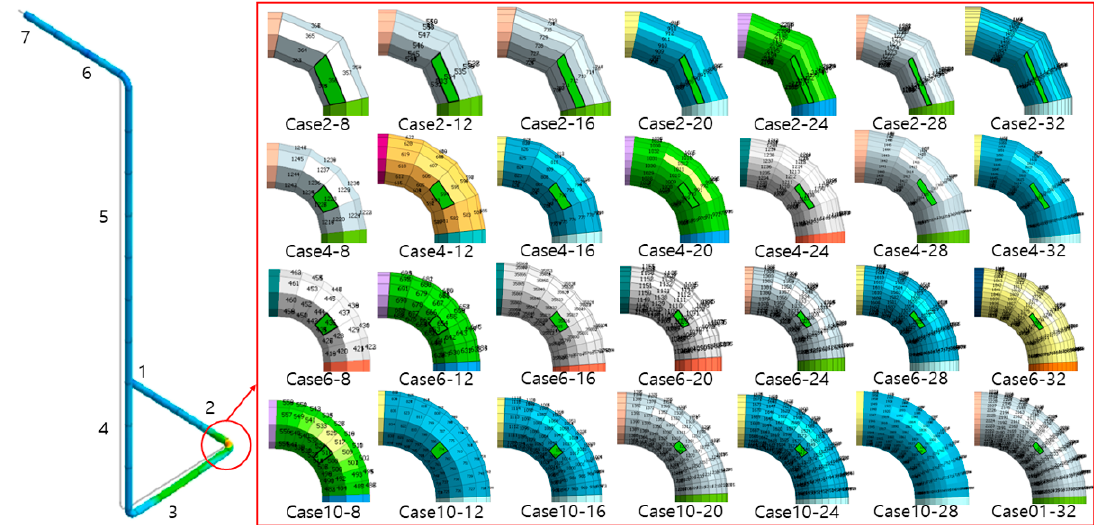
Figure 10. Pipe finite element model according to the number of elements.